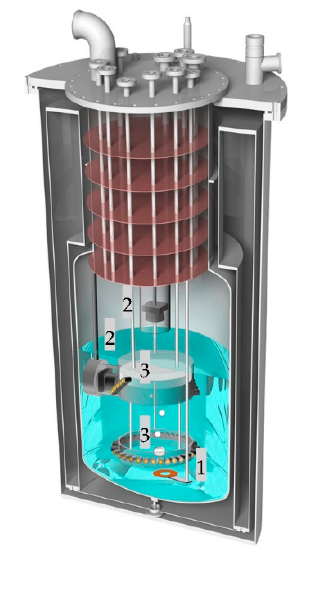
Figure 2. Cryogenic measurement